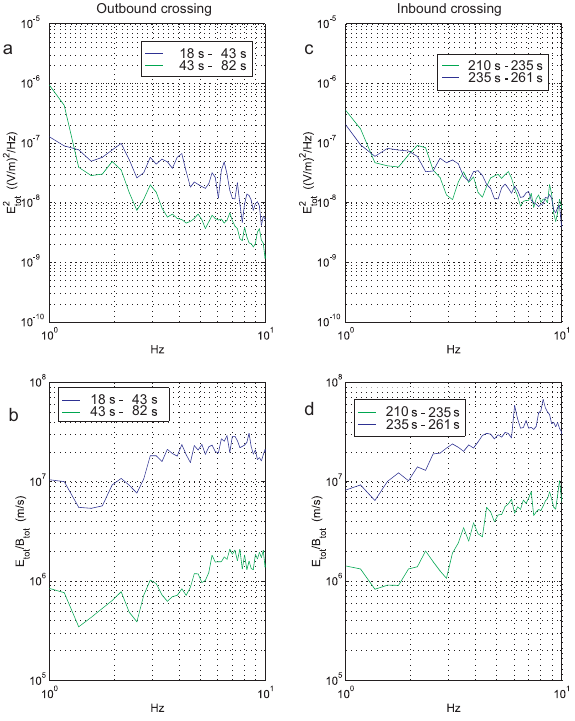
Fig. 9. (a) and (b) Electric field power spectra and E/B ratios ob- tained when satellite 4 is leaving the magnetosphere, and (c) and (d) corresponding spectra when the satellite is entering the magne- tosphere. The blue line correspond to the Earthward part of each event. Times are in seconds after 10:17:00 UT, 31 Dec 2000. The boundary between spectra for each crossing (43 s and 235 s) are in- dicated in Fig. 3. The electric field E is the total field in the satellite spin plane, while B is the total magnetic